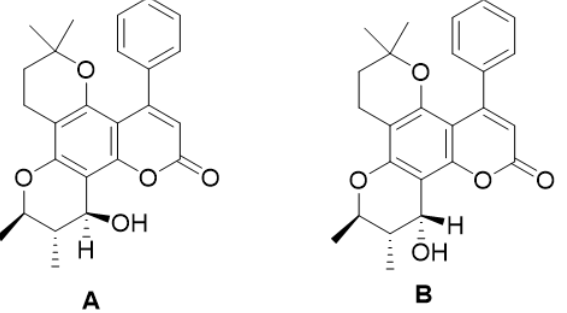
Figure 15. Chemical structured of inophillums B ( A ) and inophillums P ( B ).